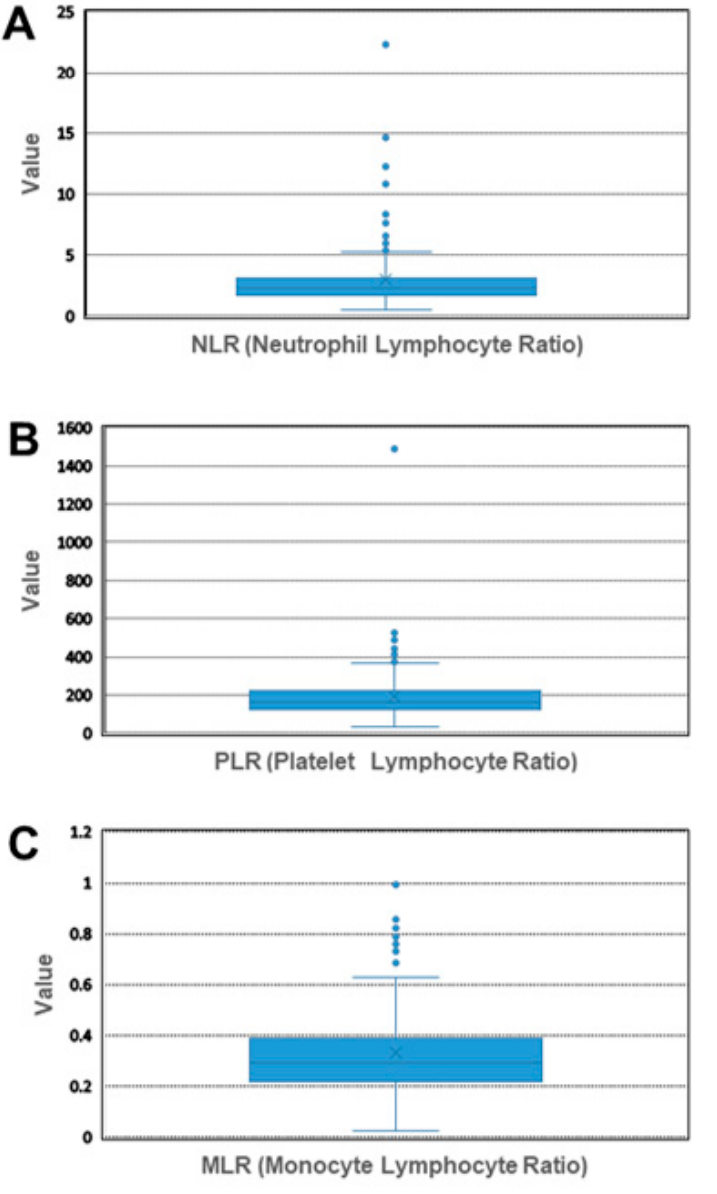
Figure 1. Box and Whisker plot of blood values. Cut-off levels for NLR ( A ), PLR ( B ) and MLR ( C ) of all patients, as determined by the 75% percentile. MLR: monocyte-to-lymphocyte ratio; NLR: neutrophil-to-lymphocyte ratio; PLR: platelet-to-lymphocyte ratio. 2.3. Correlation of NLR, PLR and MLR with Clinical Characteristics When patients characteristics as well as DTCs and CTCs were correlated with NLR, MLR and PLR, only the lymph node status was significantly related to PLR ( p = 0.029) and MLR ( p = 0.041) while CTCs significantly related to NLR ( p = 0.025) (Table 3). In more detail, patients with a high NLR ( ≥ 3.13) level had significantly more often a positive CTC-status. Patients with a high PLR ( ≥ 222.3) or high MLR ( ≥ 0.39) level, had significantly more often a